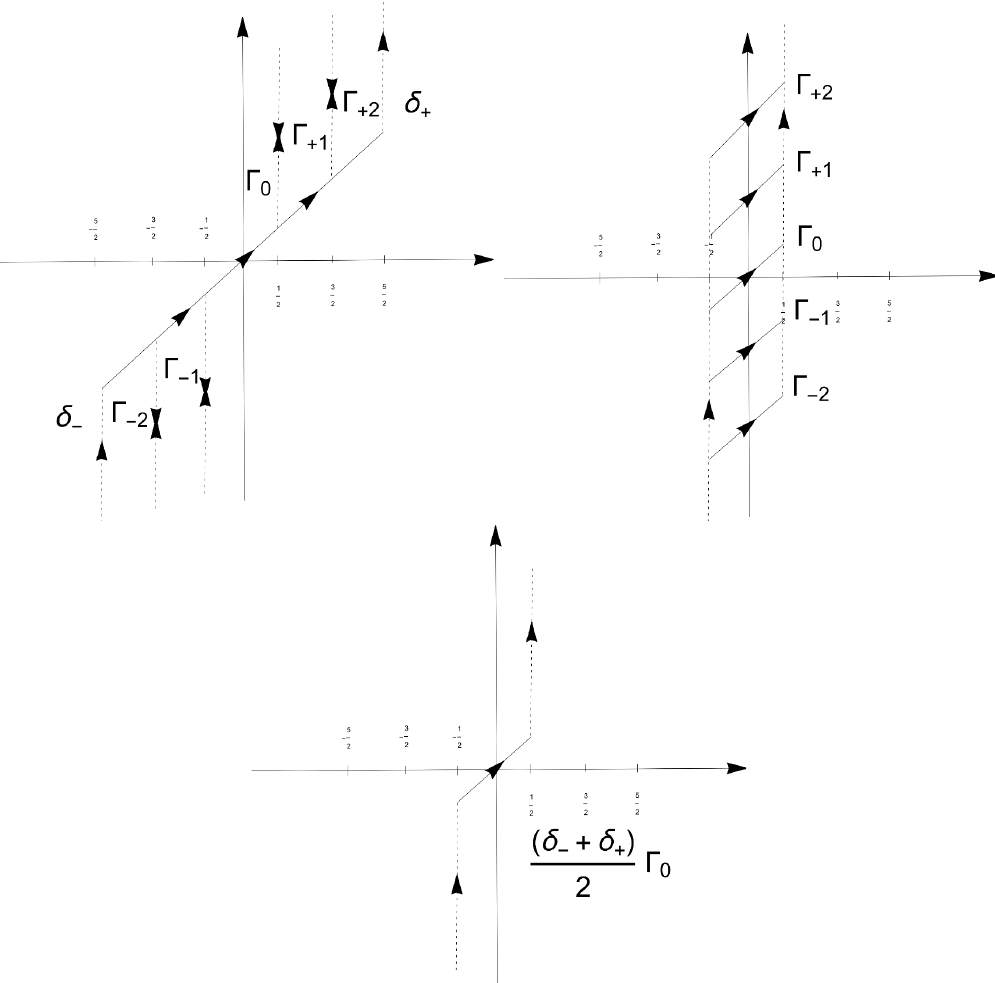
Figure 9 . First, one defines a contour that goes to infinity in the quadrants that make integral (4.15) finite, an infinitesimal deformation of the ( −∞ , ∞ ) . Then the integral is divided in subintegrals Γ p ∈ Z that can be pushed to the fundamental domain Re u ∈ [ − 1 ] by using the quasi-periodicity , 1 2 2 properties (4.12). In particular the integral along the deformed Γ has extra p -powers of the p function Q inserted. As the deformation is infinitesimal the addition of all the subintegrals can be recast as an integral over the contour Γ with the insertion of a geometric series in Q resulting in 0 denominator (1 − Q ) . The residues that compute the latter integral come from the denominator. There are many details that go into this analysis and they will be revisited